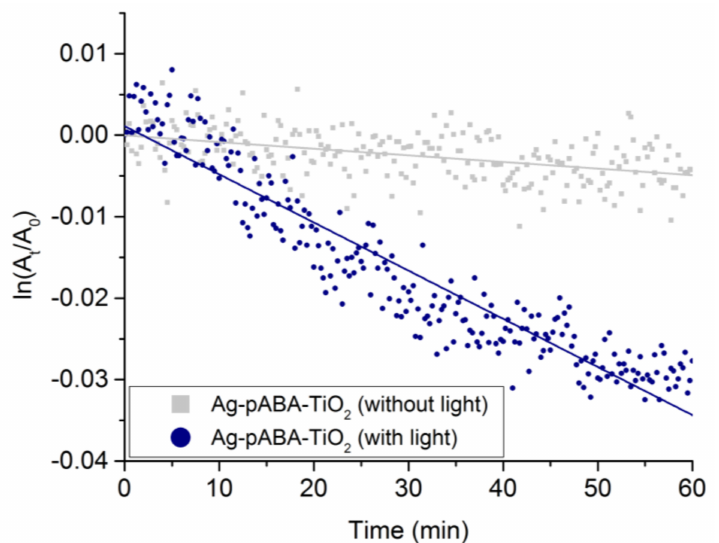
Figure 8. The disappearance rate of 4-nitrophenol (4-NP) in Ag-pABA-TiO 2 (catalyst amount of 2.5 µ g / mL), with and without laser excitation.